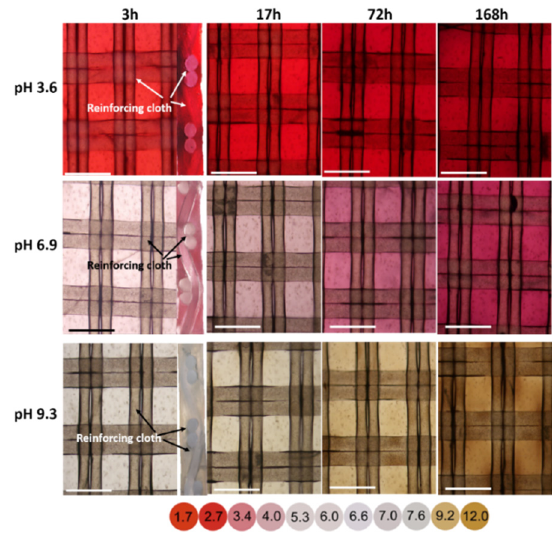
Figure 6. Optical images of the surfaces (left) and sections (right) of CJMC-5 membrane coupons that were in contact with cranberry juice for 3, 17, 72, and 168 h. Before obtaining images, these were placed for 2 h in buffer solutions at pH 3.6, 6.9, and 9.3. The dependence of cranberry juice pH (diluted 10 times) on its color is shown below the figure. The scale is 200 µ